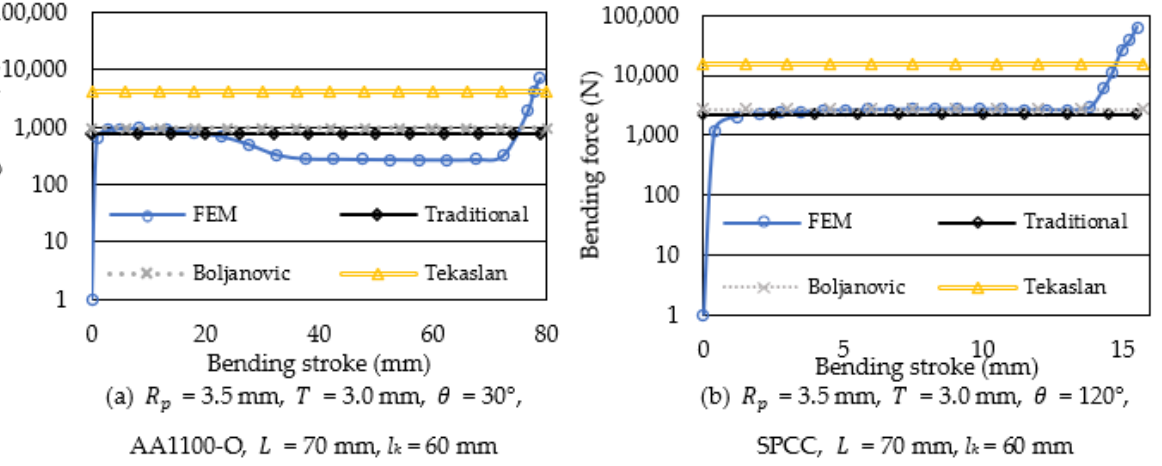
Figure 6. Comparison of bending forces obtained using the traditional, Boljanovic, and Tekaslan formulas, and FEM simulation results in the case of V-die bending with respect to various bending conditions.